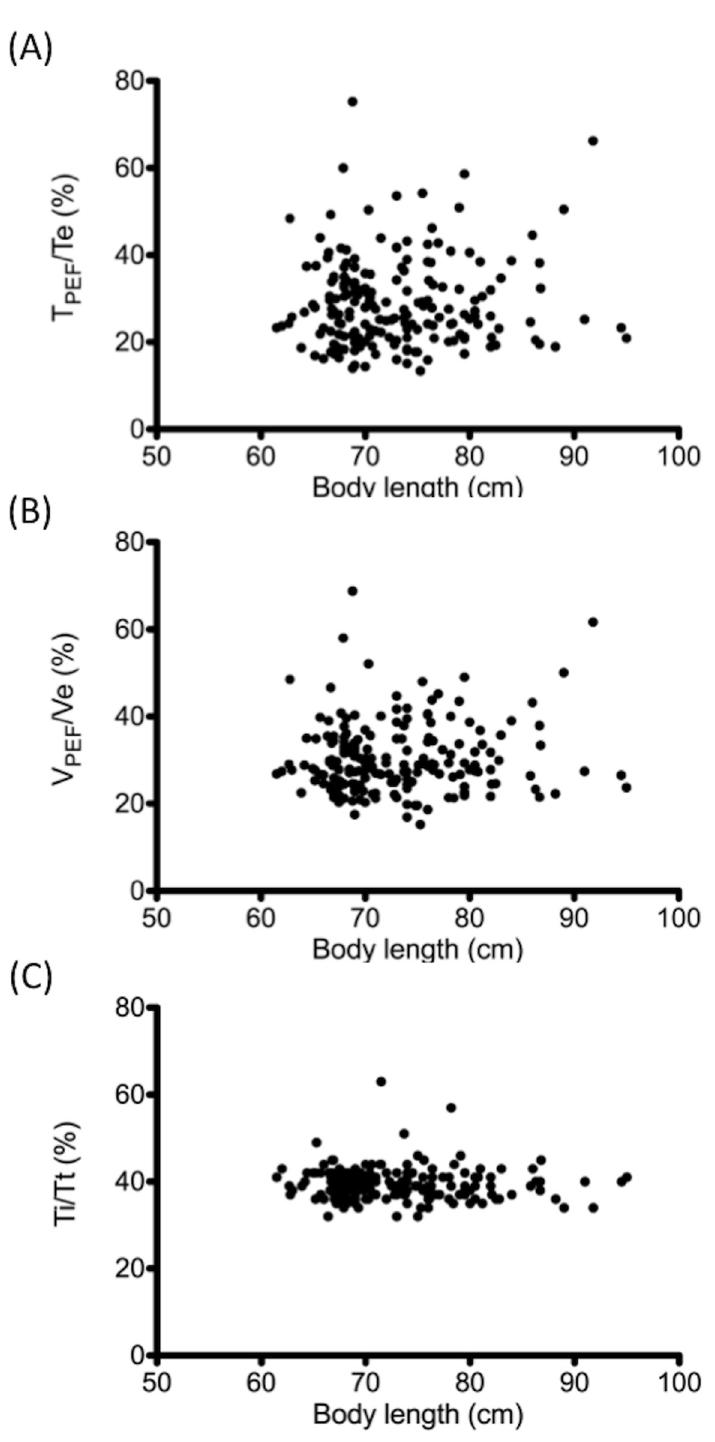
Fig 1. Parameters for tidal breathing analysis. Scatter plots of (A) T PEF /Te, (B) V PEF /Ve, and (C) Ti/Tt in tidal flow waveform are indicated against crown-heel length at the time of the test.